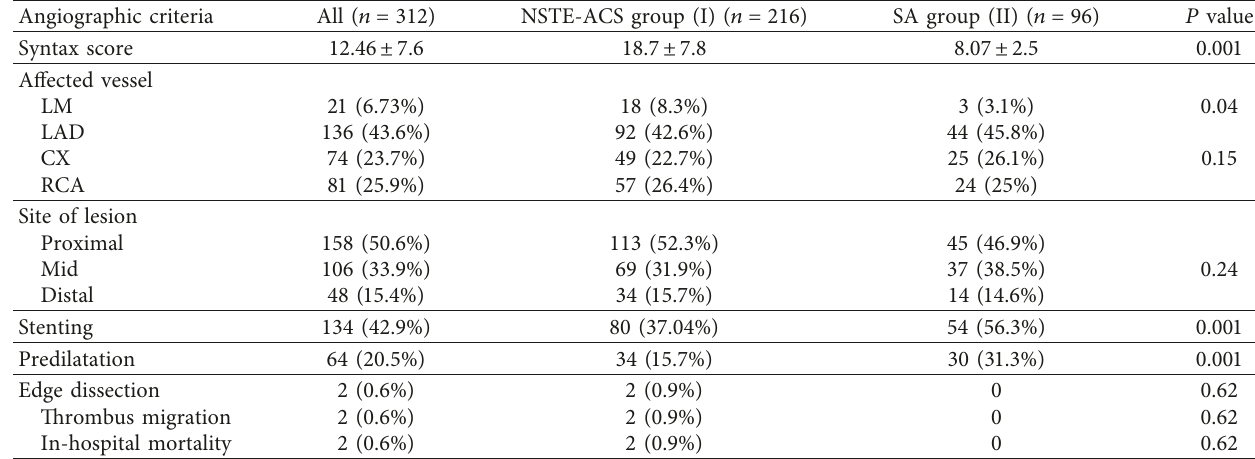
Table 2: Angiographic data of stable angina and NSTE-ACS